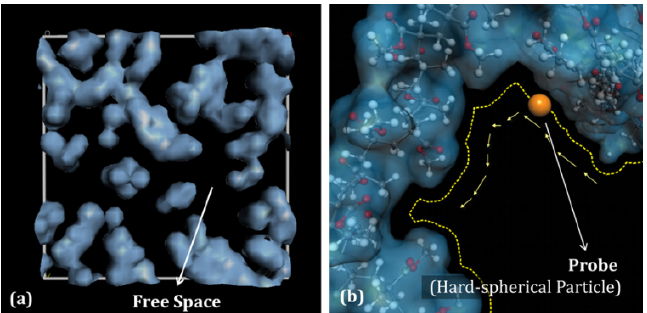
Figure 13. ( a ) Free space and ( b ) van der Waals volume in a molecular model [50].